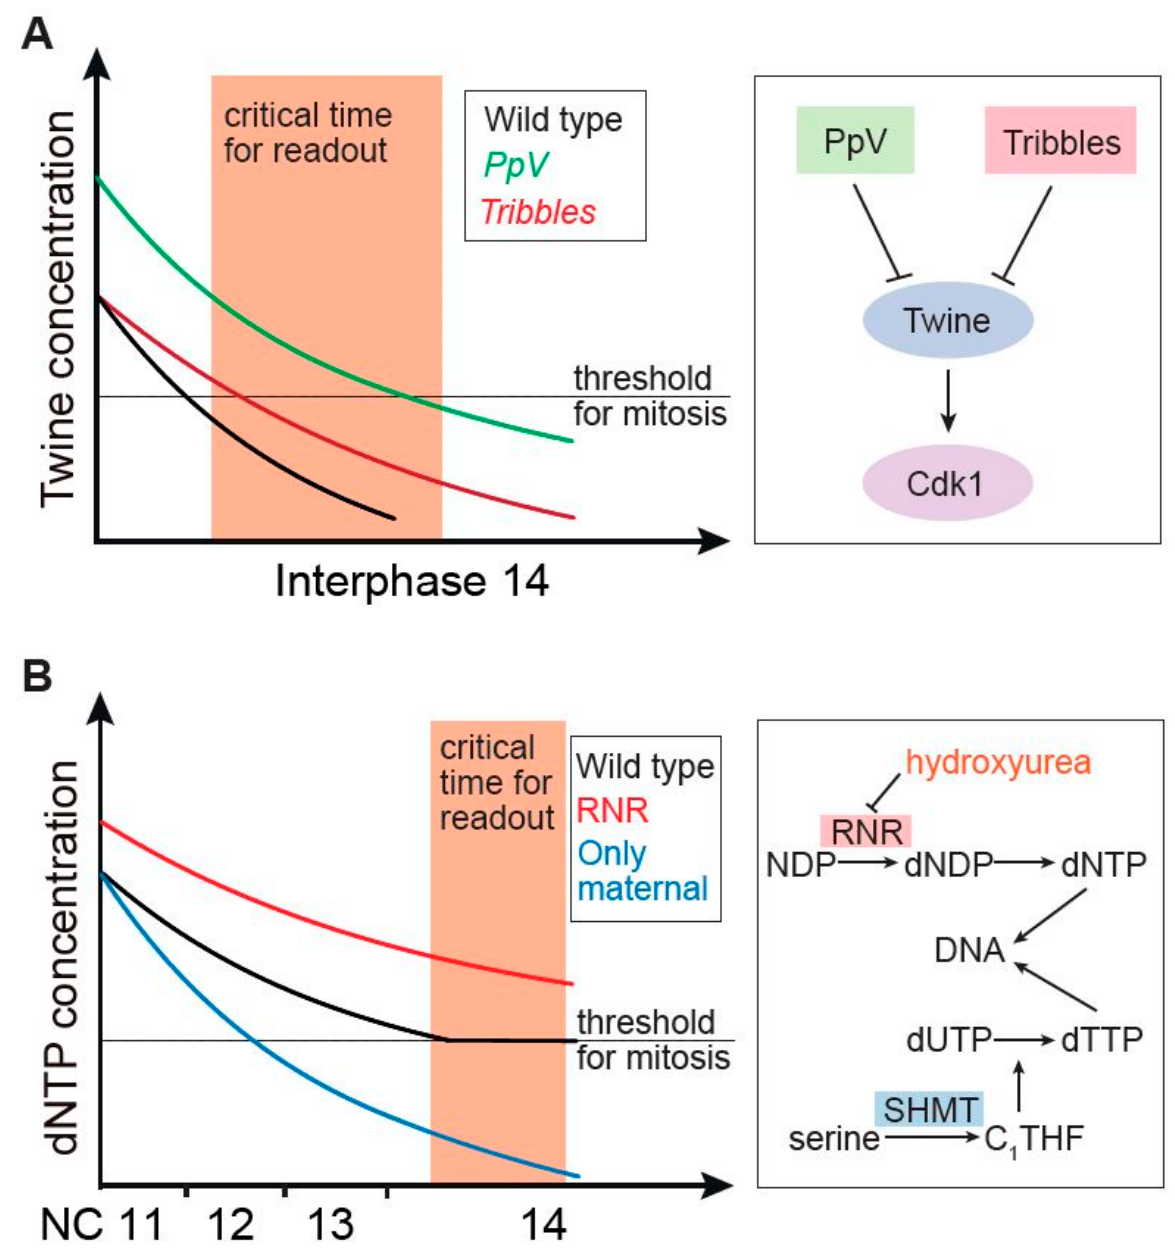
Figure 1. Temporal gradients of Twine protein and dNTP metabolites and their regulatory pathways. ( A ) Schematic temporal dynamics and threshold of Twine protein. ( B ) Schematic temporal dynamics and threshold of dNTP metabolites. NC, nuclear cycle. Critical time for readout indicates the time window when levels of Twine protein and dNTP metabolites reach the threshold to determine the mitotic entry.